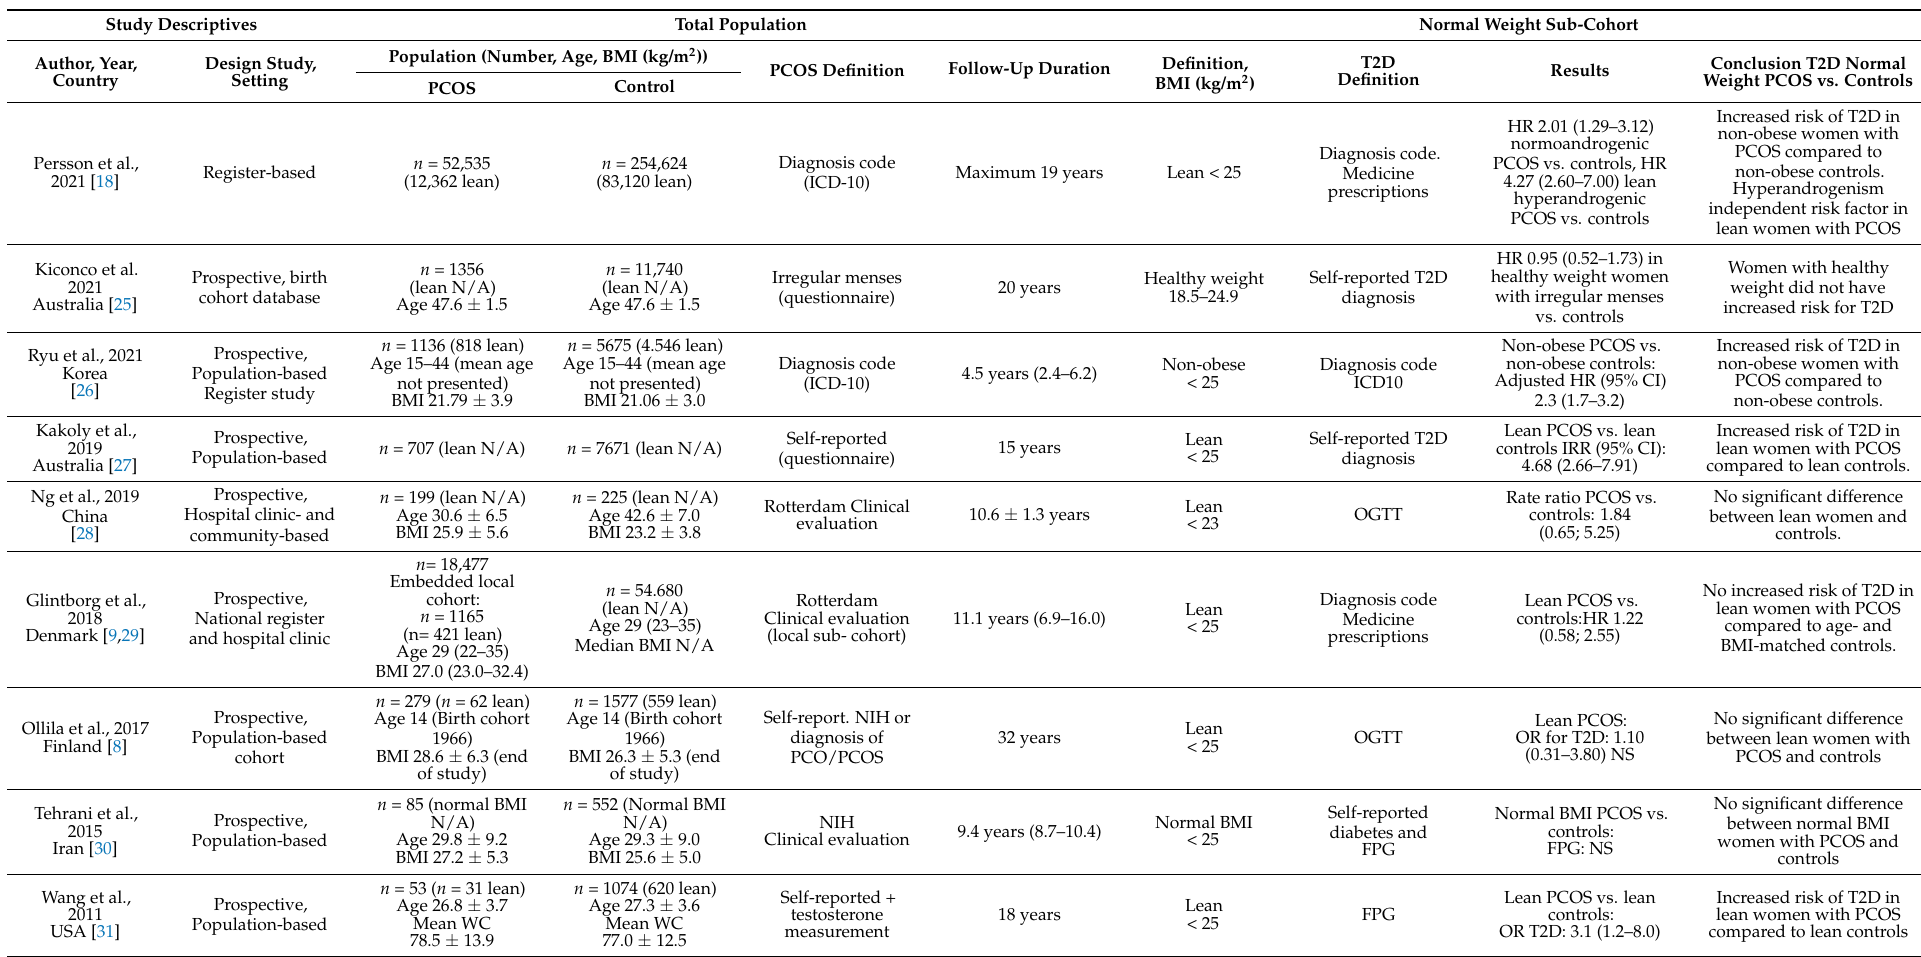
Table 1. Characteristics of included